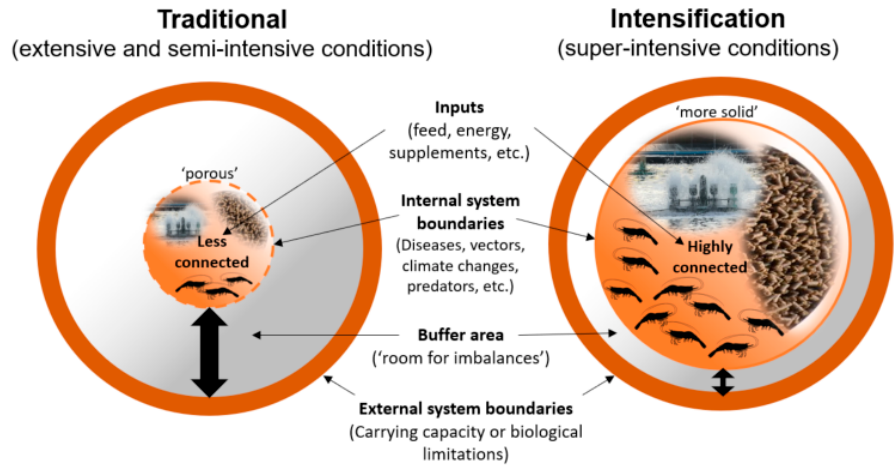
Figure 2. Comparison between traditional (extensive or semi-intensive) and super-intensive shrimp systems. The higher the inputs and degree of intensification, the less room for error.